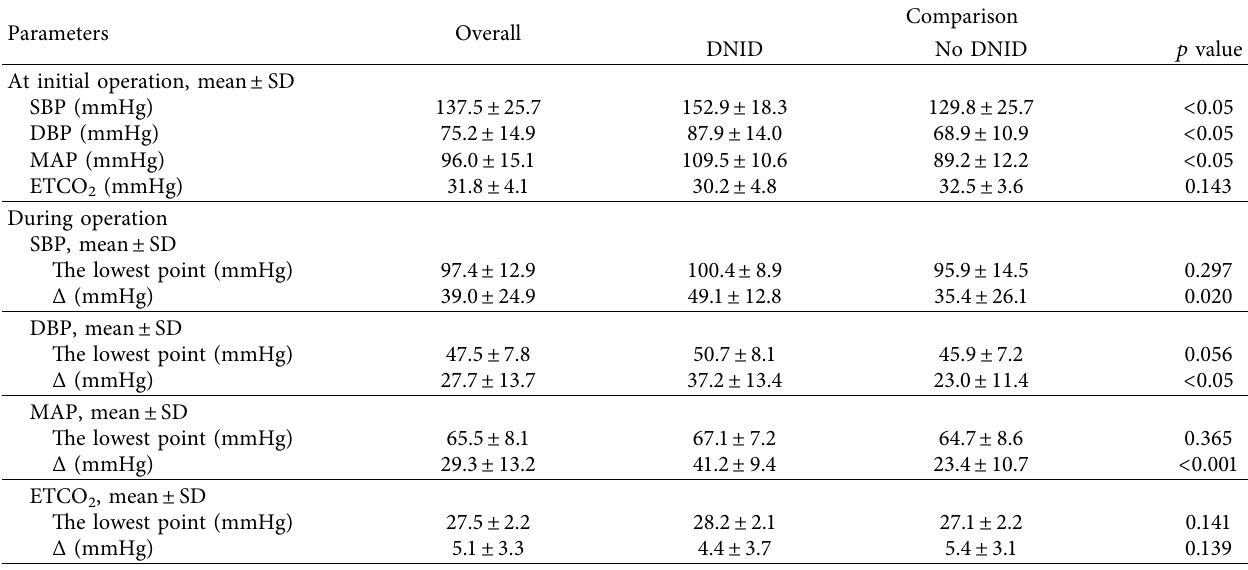
Table 2: Comparison of intraoperative hemodynamic and end-tidal carbon dioxide monitoring between patients with and without DNID.